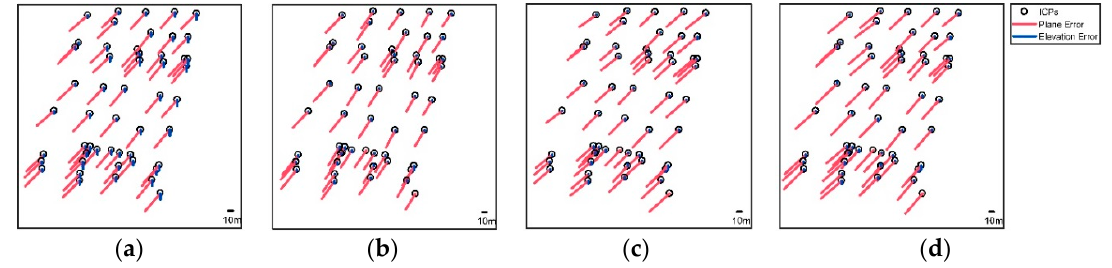
Figure 3. Residual distributions of independent check points (ICPs) of free network adjustment for the Songshan area: ( a ) Scheme 1; ( b ) Scheme 2-F; ( c ) Scheme 2-N; and ( d ) Scheme 2-B.